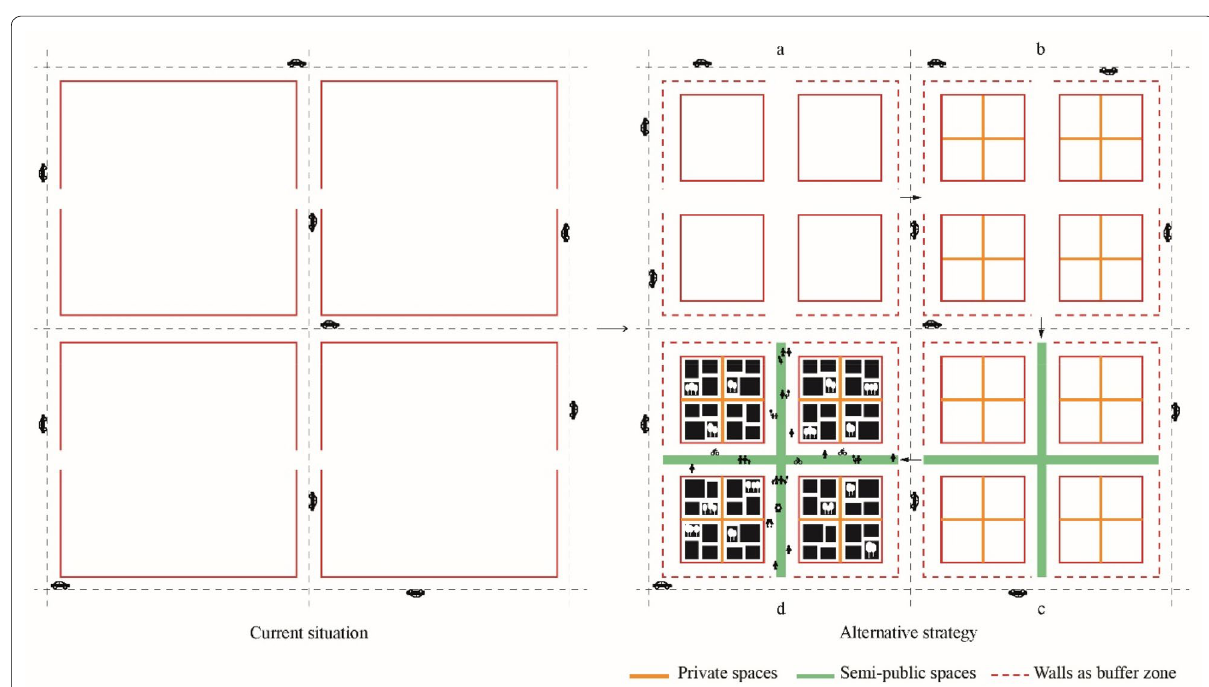
Fig. 8 a The large-scale blocks could be subdivided into small blocks. b Each small block could have its own internal subdivision and private spaces. c Streets within the large bocks are meant to be mainly pedestrian with restricted vehicle access. d Each large block could support mixed functions. The existing boundaries will function as a ‘buffer zone’ to protect the spaces within the large blocks from noise and pollution, assuring